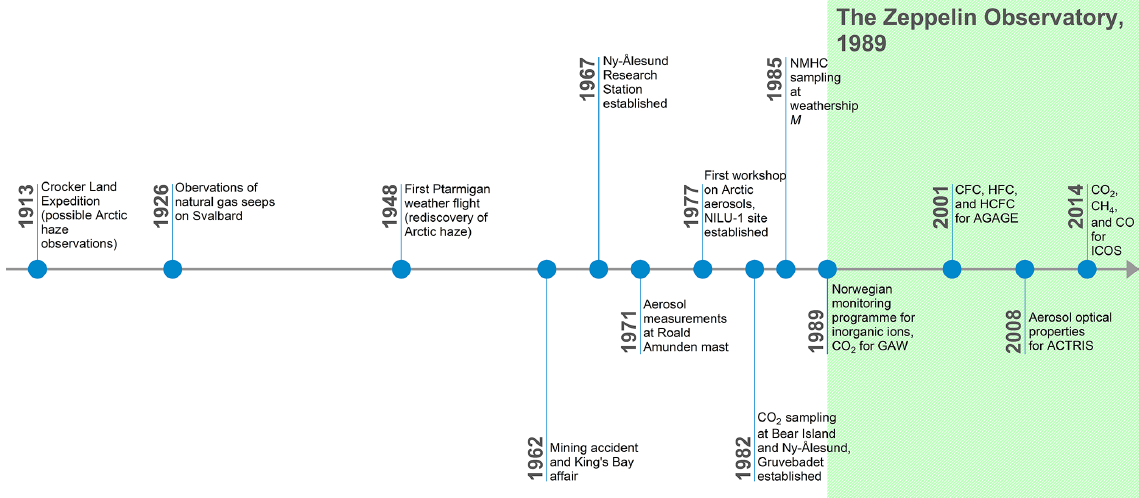
Figure 1. Timeline of Arctic measurements leading up to the construction of the Arctic observatory, and selected subsequent milestones, mentioned in the main